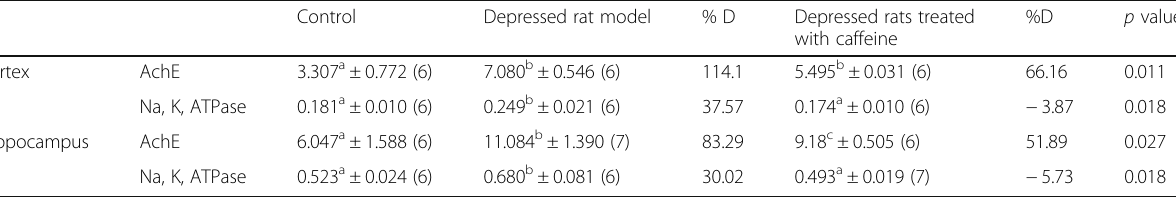
Table 2 Effect of daily caffeine treatment (30 mg/kg) on the activity of acetylcholinesterase (AchE) ( μ mol SH/g/min) and Na, k, ATPase ( μ mol Pi/min/g) in the cortex and hippocampus of rat model of depression induced by reserpine